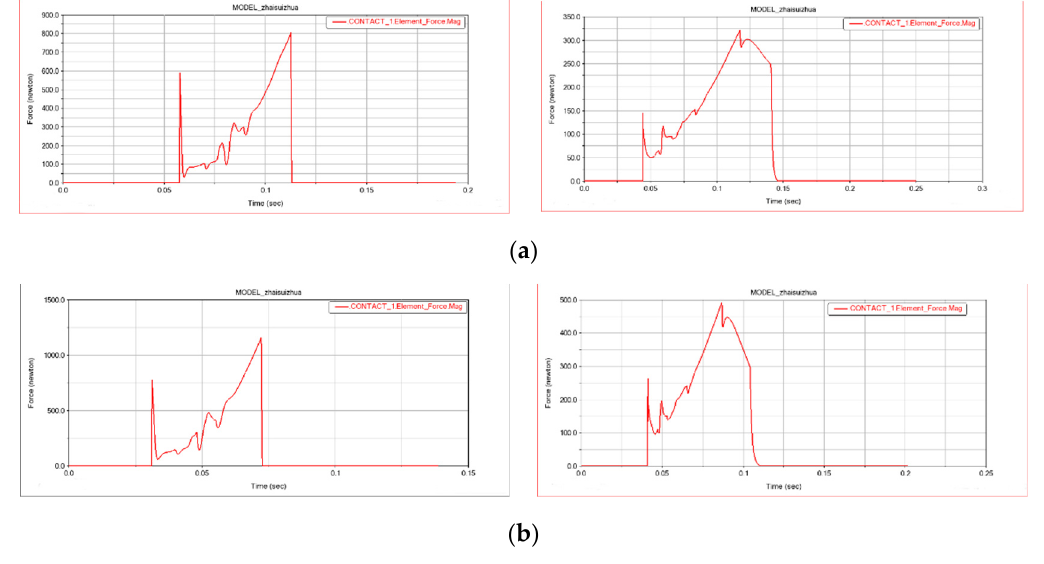
Figure 4. Contact force of ears at different claw picking speeds with a forward speed of 1 m/s. ( a ) Claw picking speed: 2 m/s; ( b ) claw picking speed: 2.71 m/s.